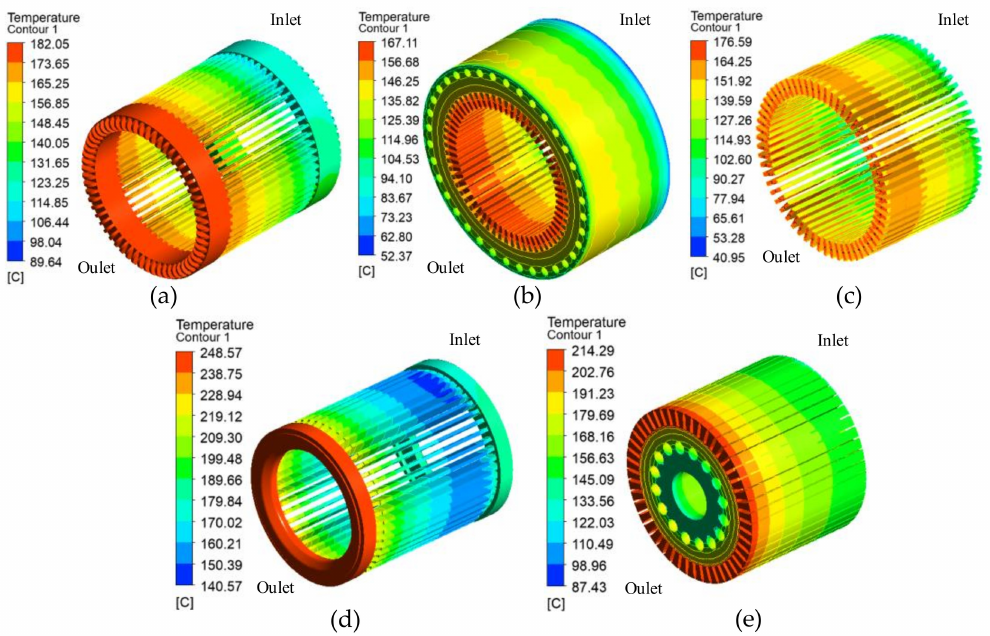
Figure 4. Temperature distribution of the original ventilation model. ( a ) Winding; ( b ) Stator core; ( c ) Insulation; ( d ) Rotor bar; ( e ) Rotor.